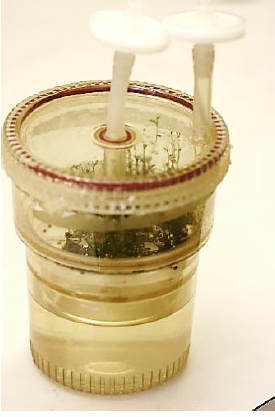
Figure 5. In vitro culture of lingonberry in a recipient for automated temporary immersion (RITA) bioreactor.